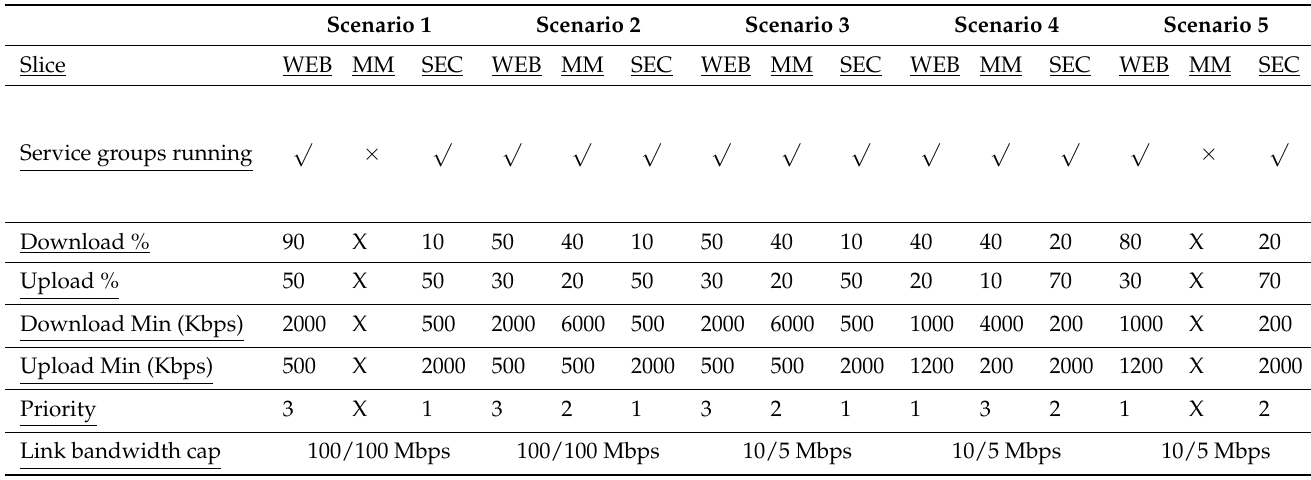
Table 3. Scenario parameters.